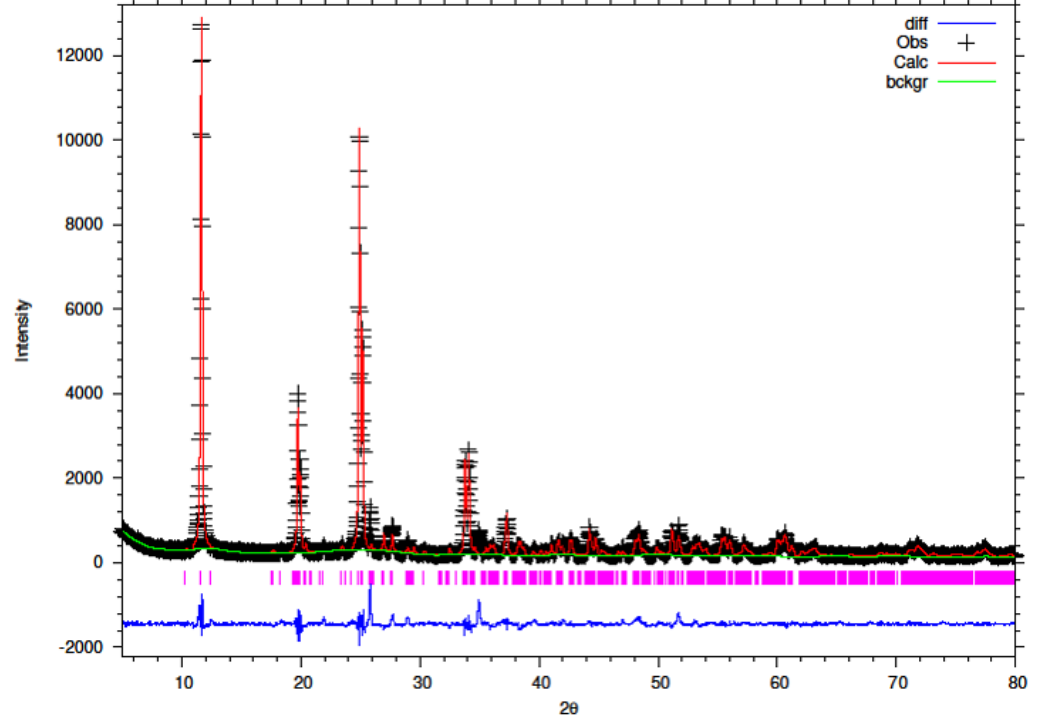
Figure 14. Final observed (cross), calculated (red line) and difference (blue bottom) Rietveld plots for hydrothermally synthesised 10% Y-ZrP. Table 9. Refined fractional atomic coordinates and isotropic thermal displacement parameters for hydrothermally synthesised 15% Y-ZrP.